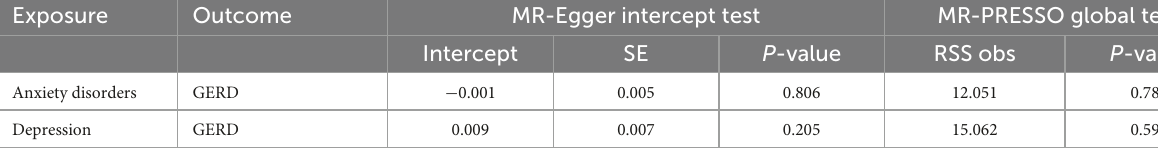
TABLE 11 Results of horizontal pleiotropy by the MR-Egger intercept test and MR-PRESSO global test in reverse MR analysis.